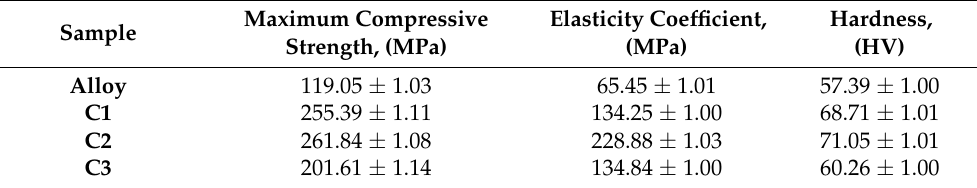
Table 2. The values of compressive strength, elasticity coefficient and hardness of alloy and composites. Maximum Compressive Sample